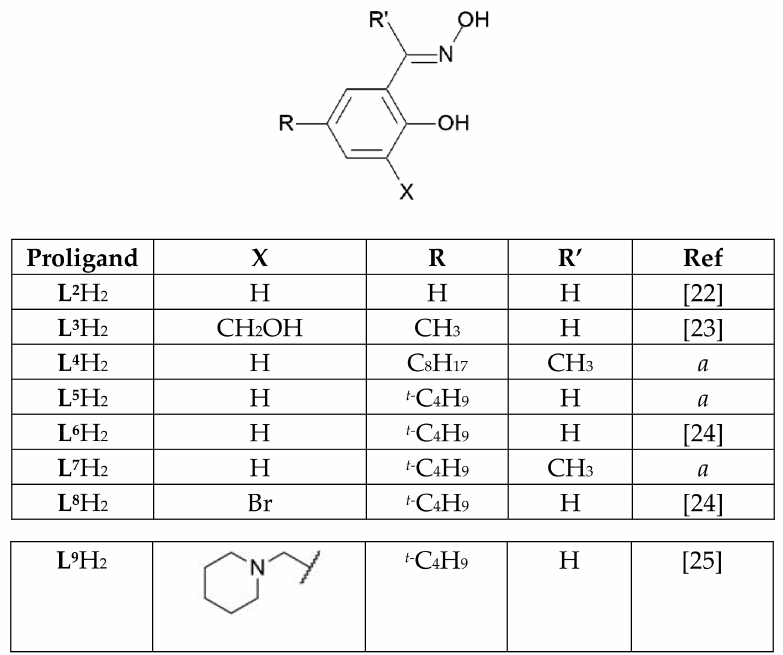
Figure 3. The phenolic oxime extractants and related proligands studied in this work. a —Details of synthesis and characterization can be found in the Experimental Section.